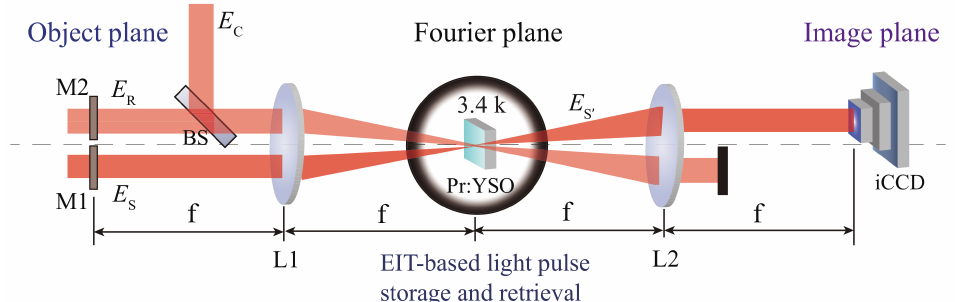
Figure 9. The 4 f -imaging system for direct optical convolution operation of two input signals through the light pulse storage and retrieval technique based on the EIT effect in Pr:YSO crystal. M1 and M2 are two masks placed on the front focal plane of lens L1 to modulate the input signal and readout fields. The Pr:YSO crystal is placed on the confocal Fourier plane of the 4 f -imaging system. The iCCD is placed on the rear focal imaging plane of lens L2 to record the convolution results. The focal length of both L1 and L2 is 30 cm.